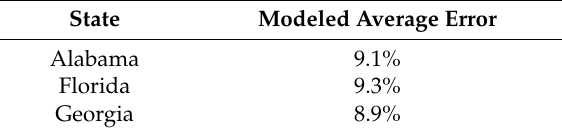
Table 3. Softmax neural network land cover model average error for each